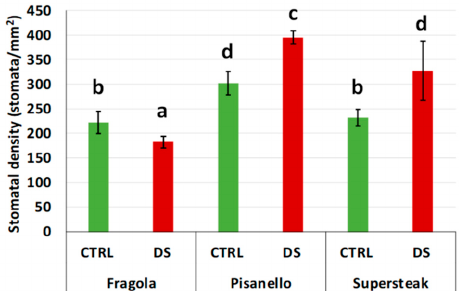
Figure 9. Stomatal density in two local varieties (‘Fragola’ and ‘Pisanello’) and one commercial cultivar ‘Supersteak’ of tomato ( Solanum lycopersicum L.) subjected to drought stress (no water for 16 days) relative to the controls (regularly well-watered plants). Two-way factorial ANOVA followed by Tukey post-hoc test was used to determine the statistical significance of differences. Points with the same lower-case letters do not differ significantly ( p > 0.05).